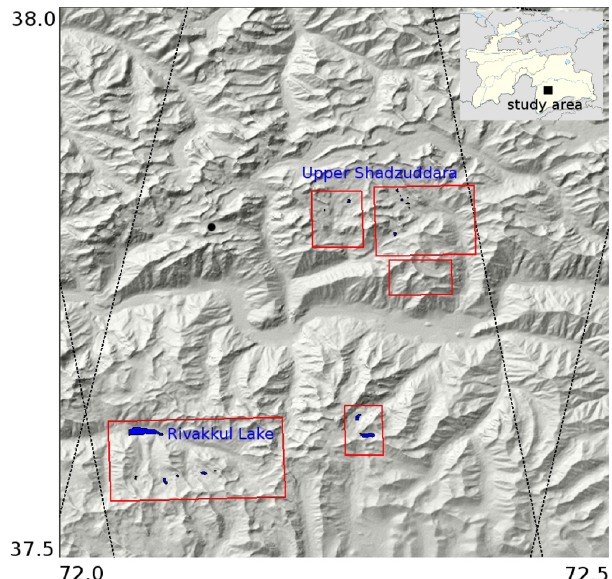
Fig. 2. Location map of the areas of interest in Tajikistan (red frames) with footprints of the TerraSAR-X acquisitions (black frames). Image background is a shaded relief of the SRTM DEM. The figure inset shows the location of the lakes in